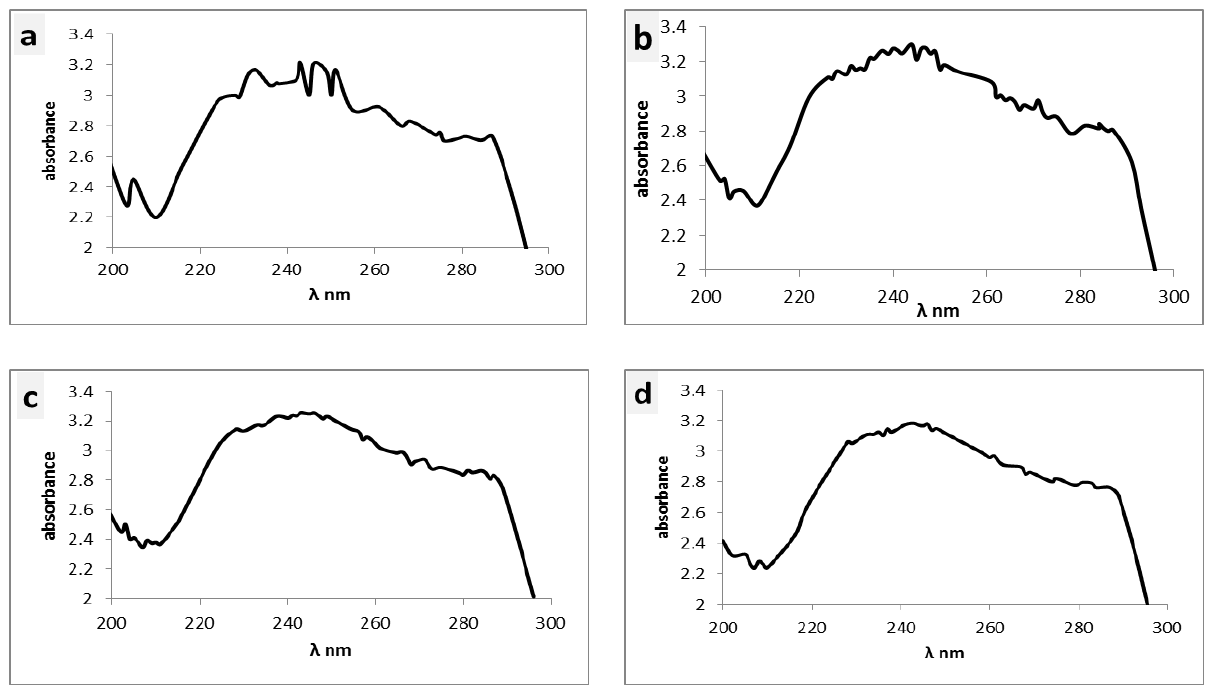
Fig.4: UV absorption spectrum of CNPs suspensions in ethanol at different laser pulse a) 25 pulse